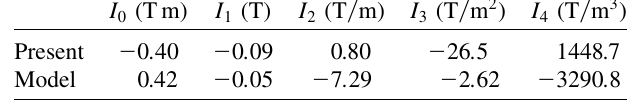
TABLE VI. Poles cut around the average beam trajectory: integrated coefficients of the field expansion as a function of the beam-wiggler misalignment in the central and the points 3 T are put in evidence. 3